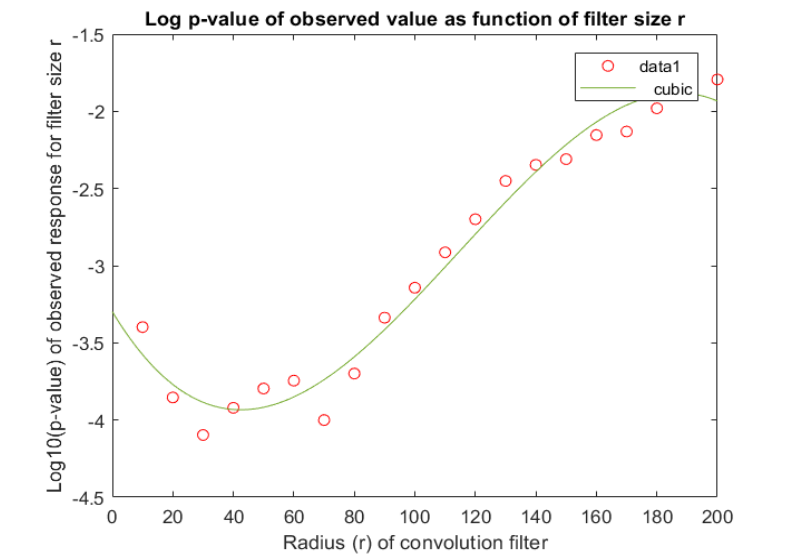
Figure 7. Log p -values of the observed responses ( T ( r ) ) as function of r . From this graph we conclude that r = 50 is a reasonable choice for the filter size. The p -value for each r is based on 50,000 MC